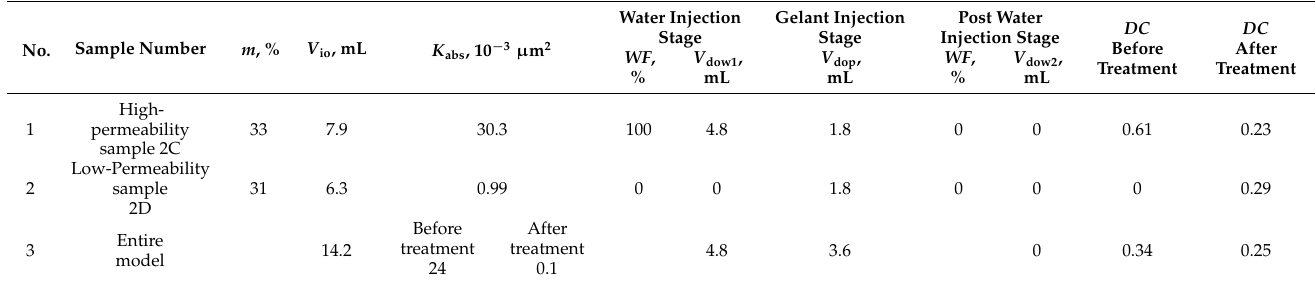
Table 9. Examination of the polymer composition without a gel-time